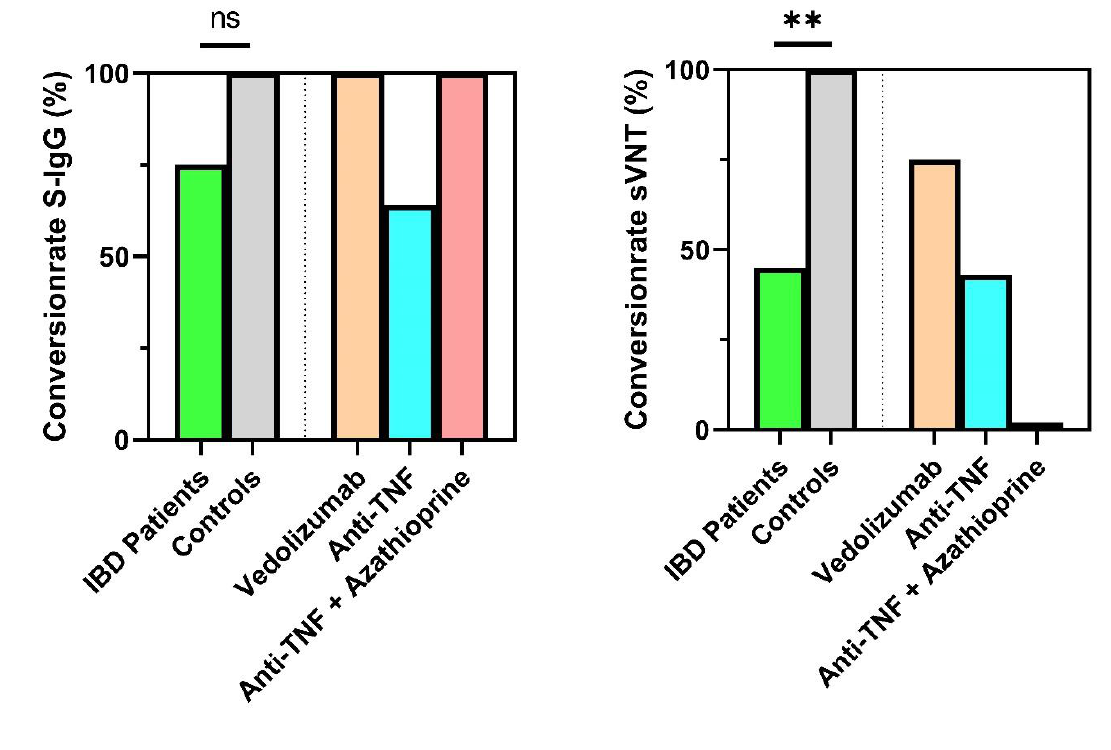
Figure 3. Humoral response of IBD patients and healthy controls 6 months after second vaccination. ( a ) Percentage seroconversion rates (SARS-CoV-2 S-IgG ≥ 50 AU/mL); ( b ) percentage sVNT inhibition. IBD: inflammatory bowel disease. ** p < 0.01. ns, not significant. Categorical variables were compared using the chi-square test or Fisher’s exact test.